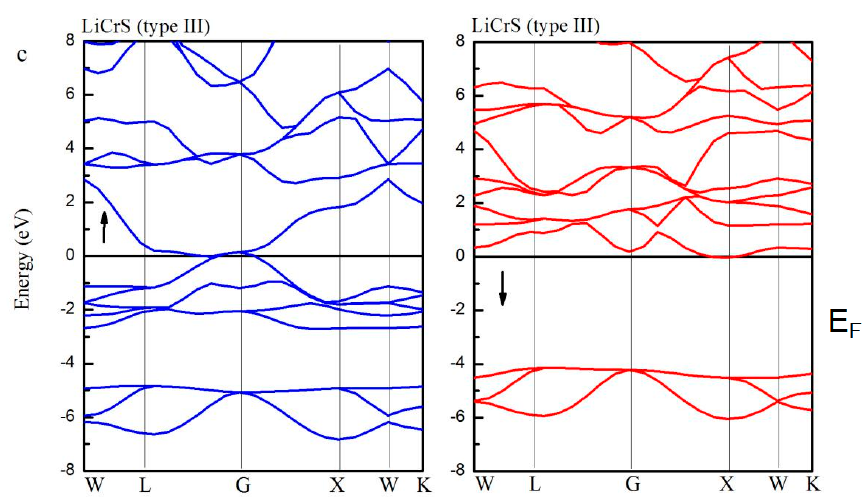
Figure 5. The spin-up (blue lines) and spin-down (red lines) band structures for LiCrS alloy in the three atomic (type I ( a ); type II ( b ); and type III ( c )) arrangements. (The Fermi level E F was set as Y = 0).